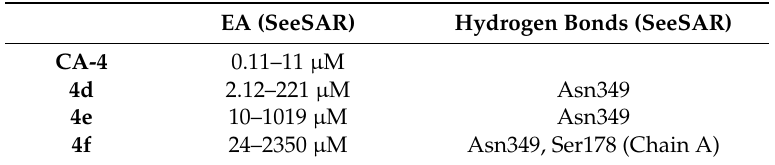
24–2350 µ M Asn349, Ser178 (Chain 24–2350 µM